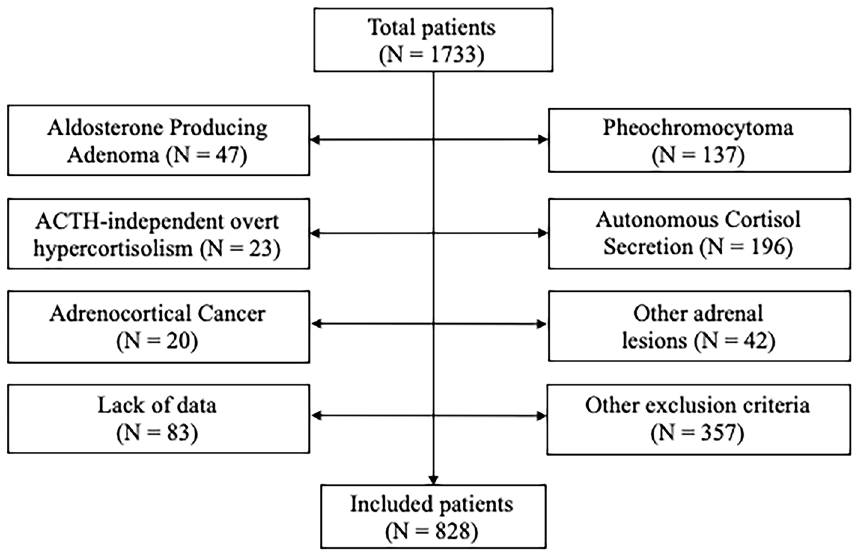
Figure 1. Study flow-chart. PPGL, pheochromocytoma or